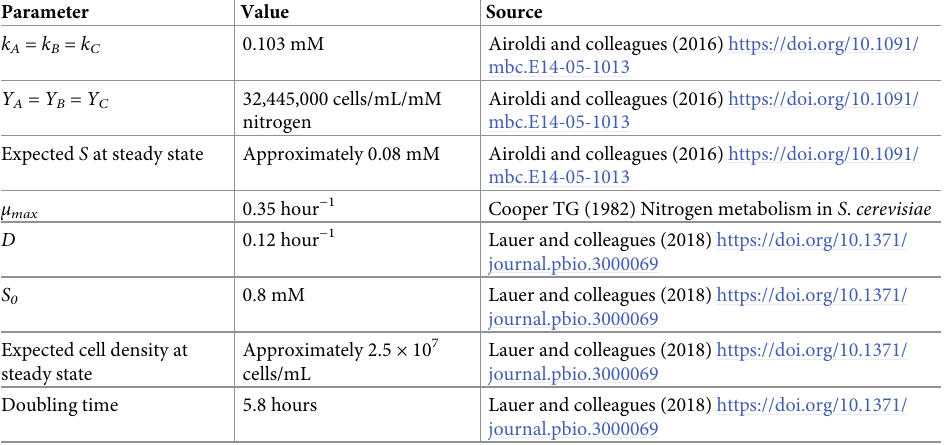
Table 1. Chemostat